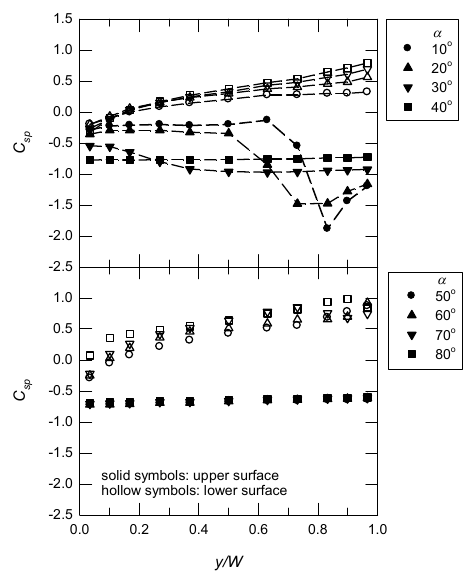
Figure 9. Mean spanwise pressure distributions at x/L = 0.5; β = 45°.